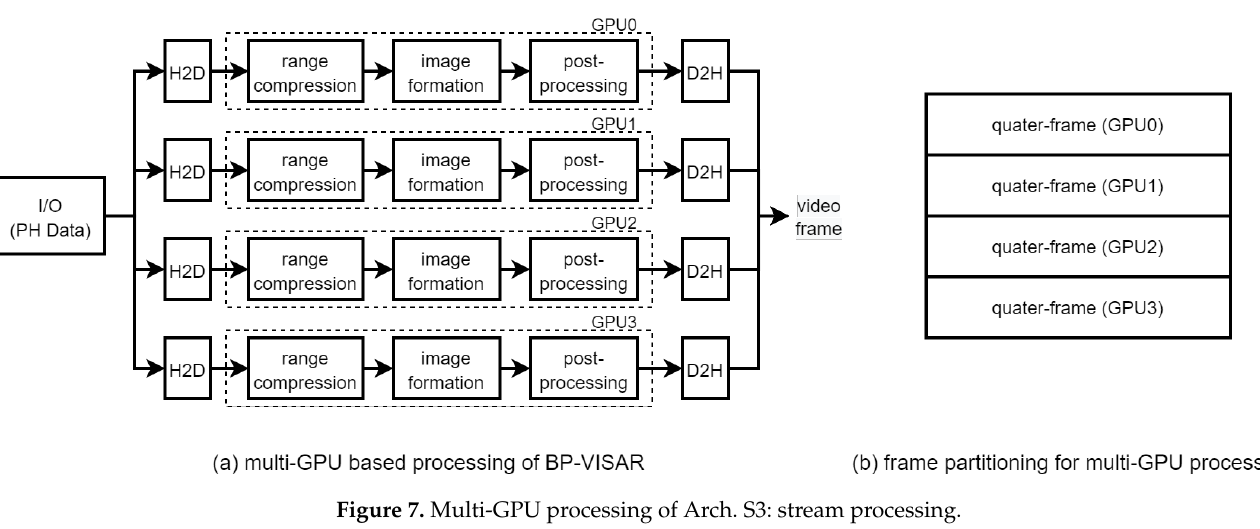
Figure 7. Multi-GPU processing of Arch. S3: stream